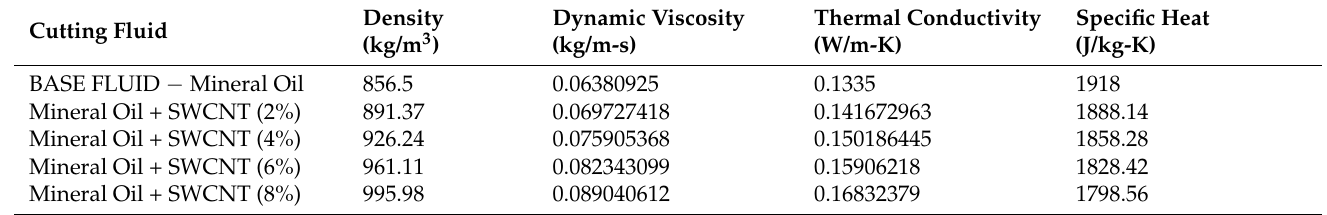
Table 3. Thermophysical and mechanical properties of mineral oil dispersed with SWCNT.